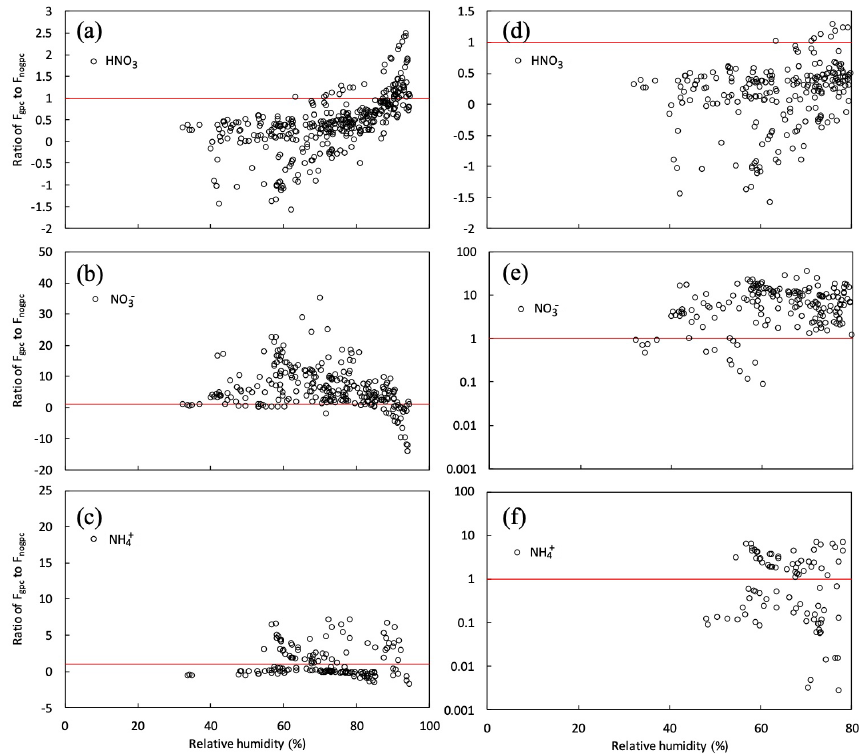
Figure 12. Relationship between relative humidity (RH) at 30m height and ratios of gpc to no gpc of calculated half-hourly fluxes ( F gpc /F nogpc ) for (a, d) HNO 3 gas and (b, e) NO − and (c, f) NH + fine particles over the canopy from 27 September to 11 October 2016. 3 4 Red lines represent the situation in which F gpc = F nogpc . Panels (d–f) plot the same variables as panels (a–c) but under dry conditions (RH <